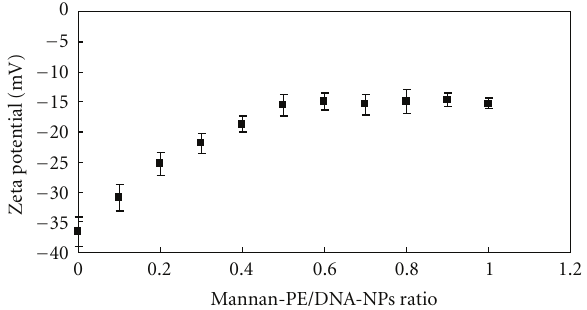
Figure 2: Optimization of mannan-modified DNA-NPs: MAN-PEs to DNA-NPs weight ratio (w/w).